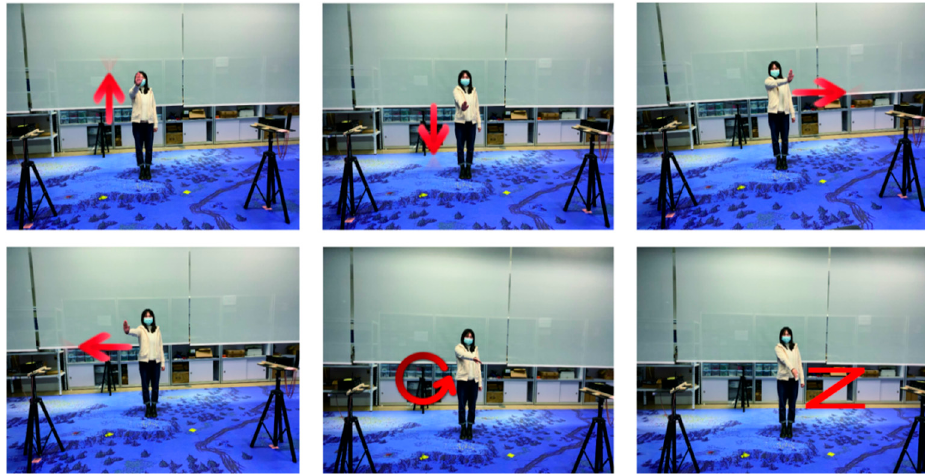
Figure 3. The six common gestures, including hand up, hand down, hand left, hand right, hand circle, and draw